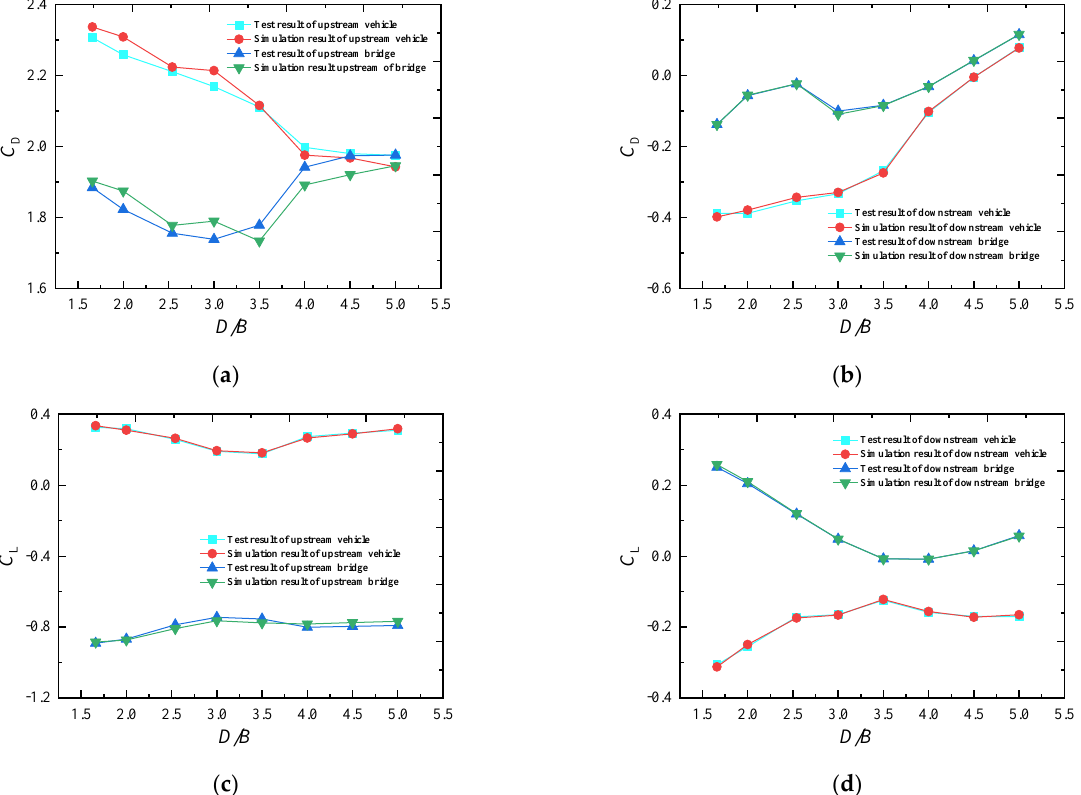
Figure 28. Comparison of the test and simulation results: ( a ) C D of the upstream vehicle – bridge; ( b ) C D of the downstream vehicle – bridge; ( c ) C L of the upstream vehicle – bridge; ( d ) C L of the downstream vehicle – bridge.